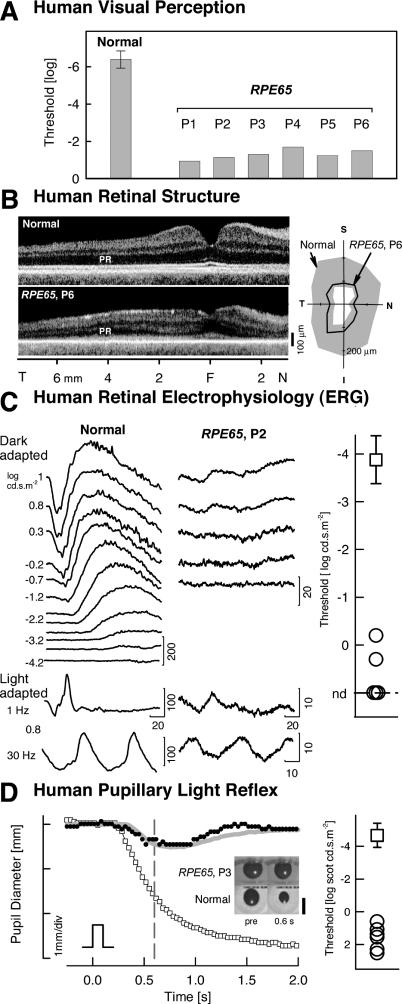
Retinal and Subcortical Dysfunction in Human LCA Due to RPE65 Mutations(A) Shown are visual thresholds to a full-field stimulus (white, 200 ms) in normal participants (±2 SD) and RPE65-LCA patients showing abnormalities of at least 4 log units.(B) Retinal structure by optical coherence tomography is shown. (Left) Cross-sectional retinal images are along the horizontal meridian through the fovea for normal (top) and patient 6 (P6) (bottom). PR, photoreceptor layer; F, fovea; T, temporal; N, nasal. (Right) Polar plot of nerve fiber layer thickness along a circle (diameter 3.4 mm) centered on the optic nerve head is shown. Gray area, normal mean ± 2 SD; S, superior; I, inferior.(C) Retinal electrophysiology by ERG is shown. Left: ERGs to white flashes in the dark- and light-adapted states for patient 2 (P2) and an age-matched normal are shown. Stimulus intensities for dark-adapted responses span 5.2 log units. Patient 2 (P2) shows recordable responses only to the higher stimulus intensities, and amplitudes are severely reduced (note 10-fold change in amplitude scale). Calibration bars are in μV for amplitude and ms for time; stimulus onset is at trace onset. Right: Summary results from patients (circles) show dark-adapted threshold elevations in excess of 3.5 log units from normal (square, mean ± 2 SD). nd, nondetectable.(D) Brainstem responses using TPLR in normal participants and RPE65-LCA patients are shown. Left: Change in horizontal pupil diameter evoked by light stimulus in a normal individual (unfilled squares) compared to patient 3 (P3) (filled symbols) is presented. The smaller and slower pupil response in the patient resembles the normal response to a 5.7 log unit dimmer flash (gray line). Response thresholds were determined at 0.6 s (vertical dashed line). Inset: Images of the pupil before and 0.6 s after a stimulus (2.3 log scot-cd.m−2; 100 ms; green). Calibration bar, 6 mm. Right: Summary results from patients (circles) showing threshold elevations in excess of 4 log units from normal (square, mean ± 2 SD).